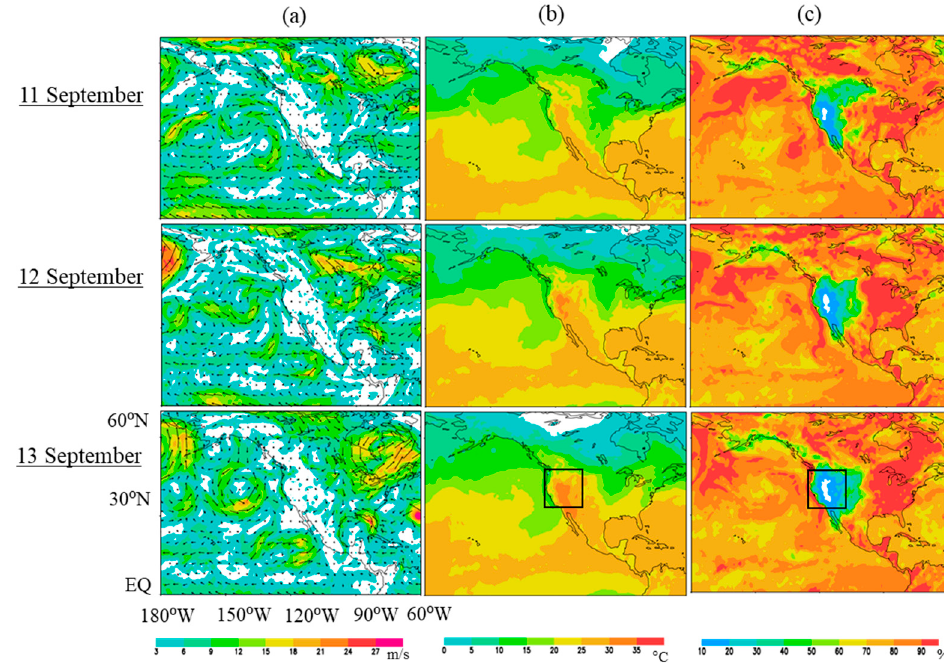
Figure 3. Meteorological data from the National Center for Environmental Prediction - Final Model (NCEP FNL) at 12:00 UTC on 11–13 September 2020 [39]. ( a ) Wind speed at 850 hPa (m/s), ( b ) tem- perature at 1000 hPa (°C), ( c ) relative humidity at 1000 hPa (%). The black box indicates Area-S. Chart resolution (1 ° × 1 ° ).